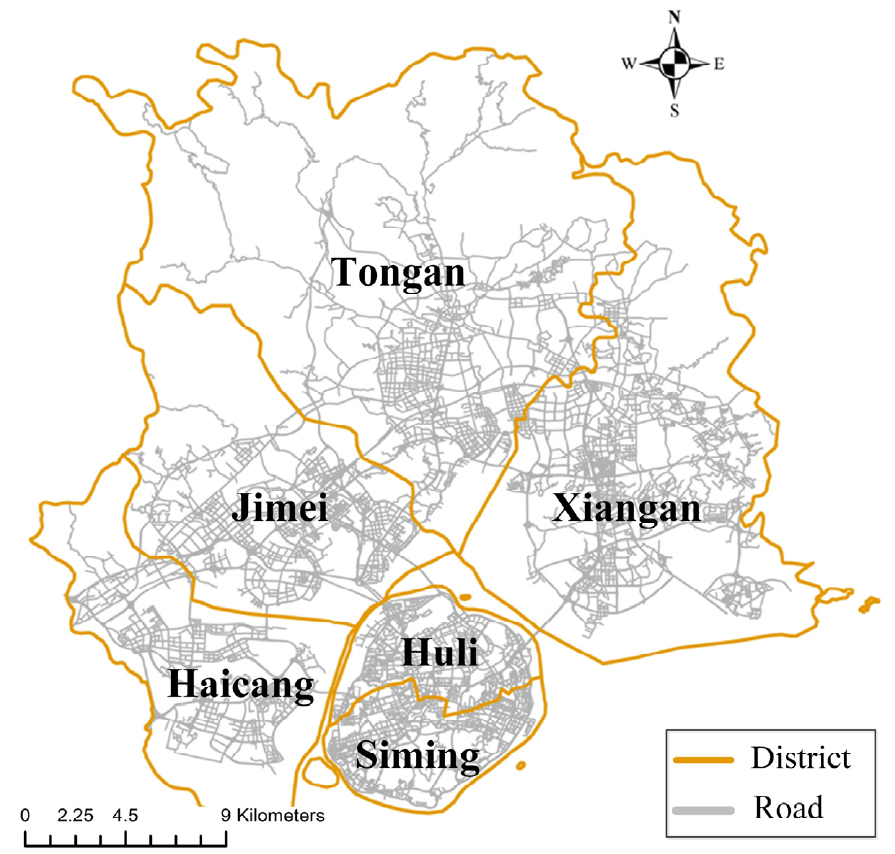
Figure 6. Study area.